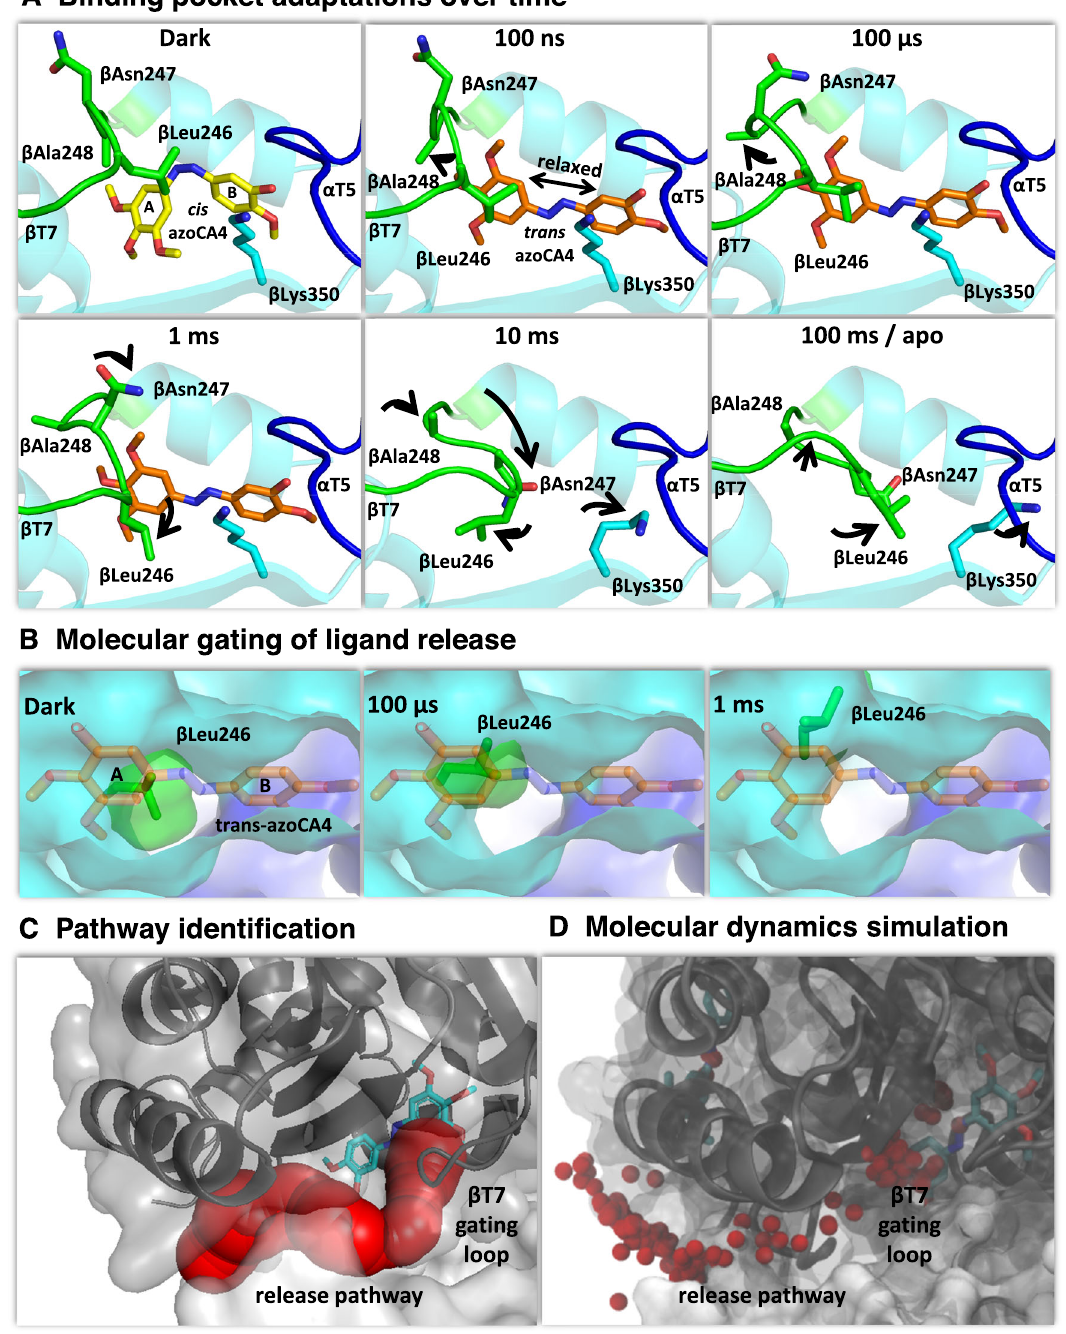
Fig. 3 | Molecular changesin the β T7gating loop allowligand release.A Within nanoseconds,thelight-inducedisomerizationandrelaxationrepositionstheAring ofazo-CA4closertothe β T7loop(green),whichactslikealidonthecolchicinesite. Further reorganizations (black arrows) in the microseconds open a channel between the β H8 helix and the β T7 loop. In the millisecond range, the β T7 loop is foldedbackandpackedagainstresiduesoftheemptybindingpocket. B Openingof